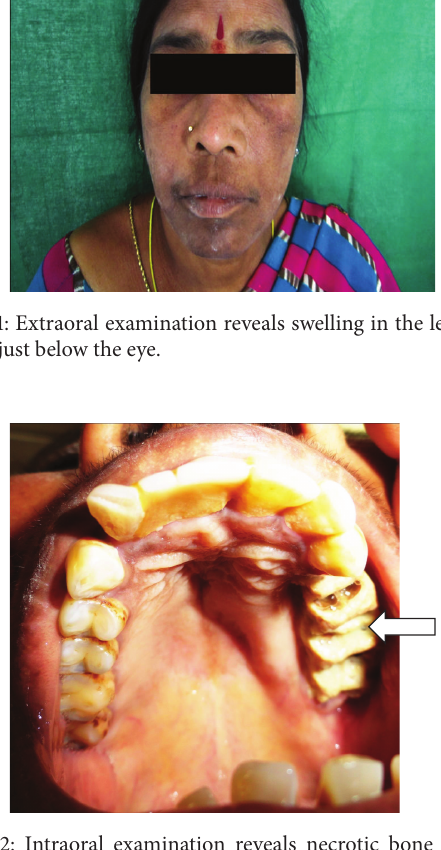
Figure 2: Intraoral examination reveals necrotic bone with pus discharge in relation to left maxilla (white